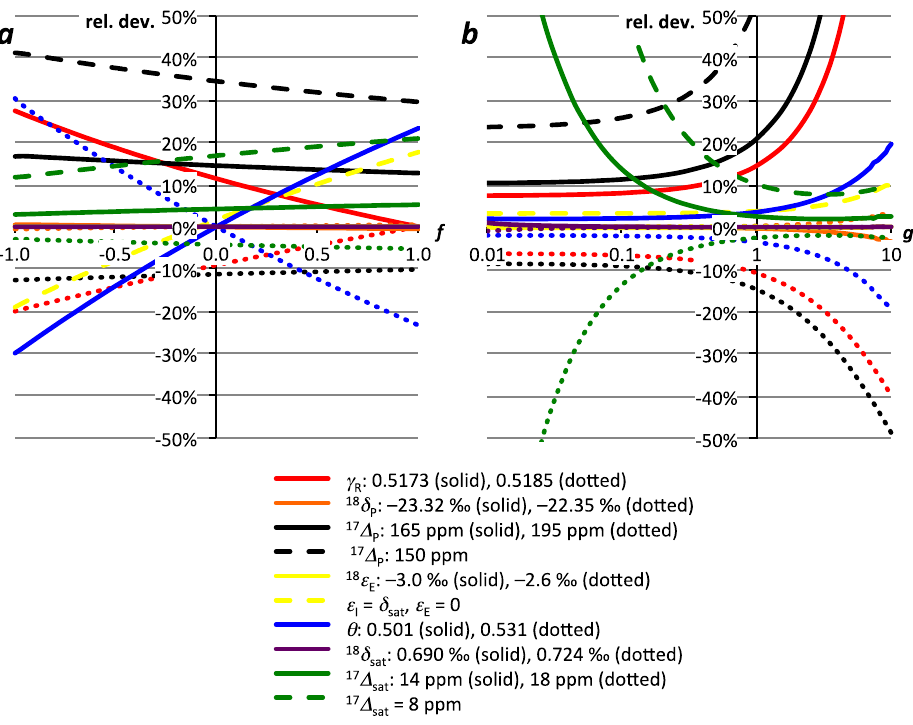
Fig. 2. Relative deviation of g from the base case (see Table 2) for different parameters in Eq. (7). Panel (a) corresponds to g = 0 . 4 and a range of f from − 1.0 to +1.0 (negative values correspond to net heterotrophy, positive value to net autotrophy). Panel (b) corresponds to f = 0 . 1 and range of g from 0.01 to 10 (logarithmic axis).